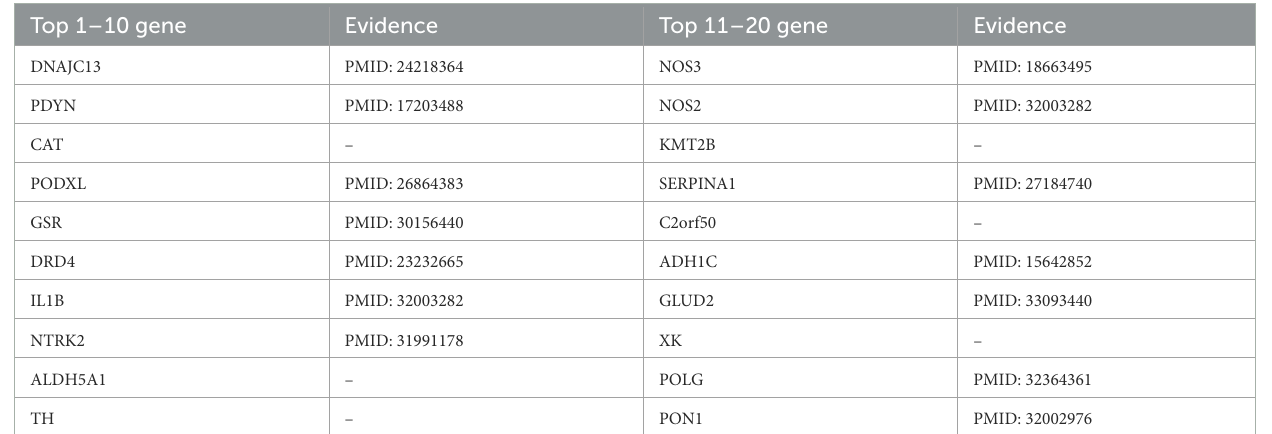
TABLE 7 Top 20 related genes of PD predicted by PSNE. Top 1–10